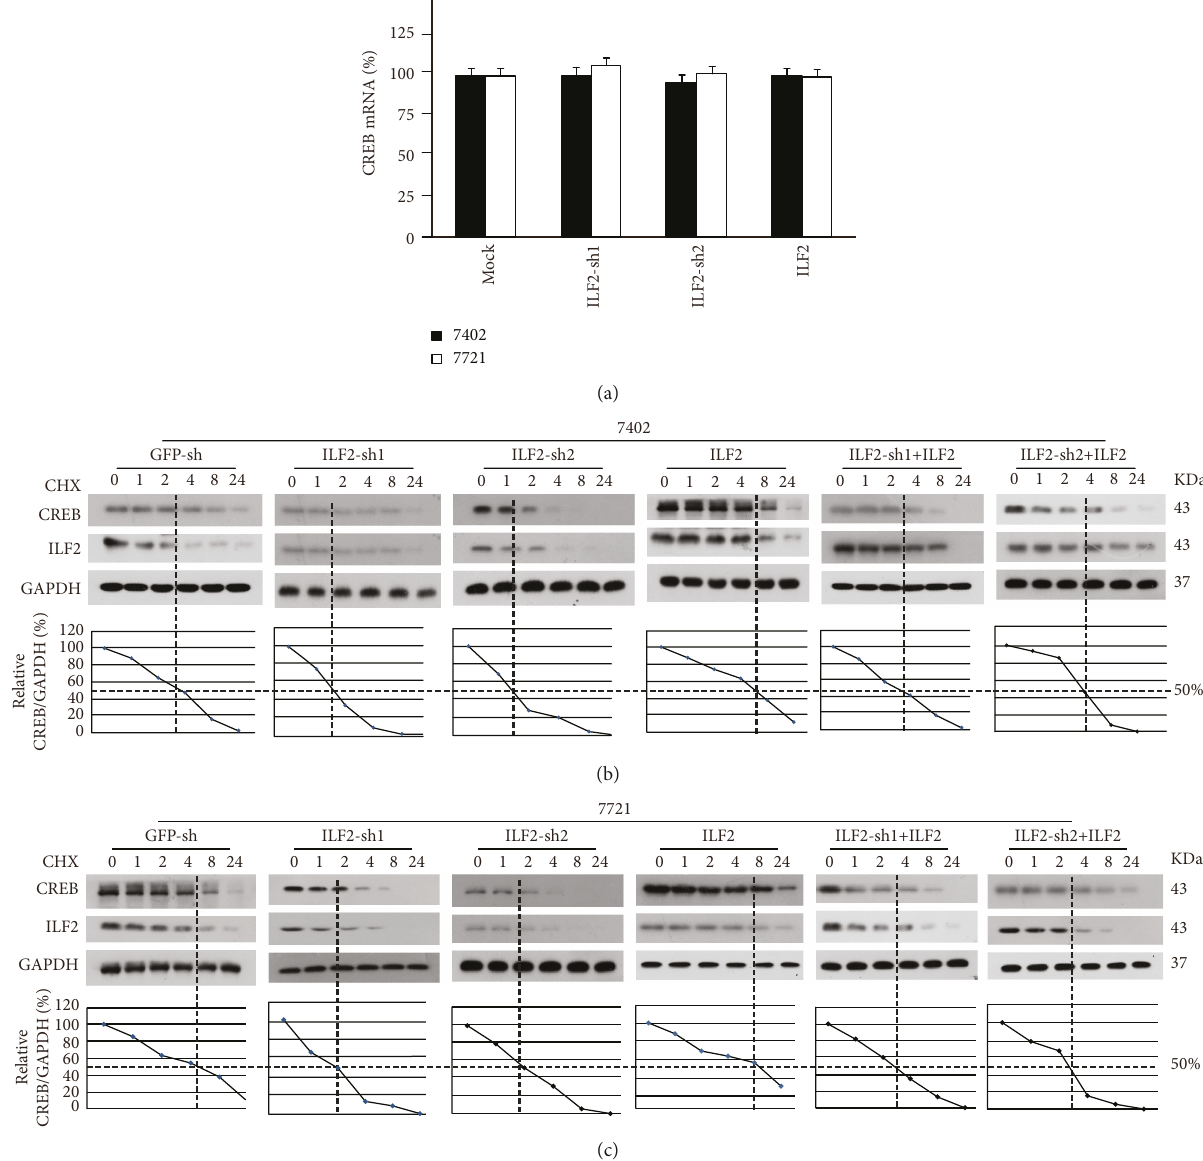
Figure 4: ILF2 enhances CREB protein stability. (a) The mRNA level of CREB was tested by qPCR in control and Bel-7402 or SMMC-7721 cells with knockdown and overexpression of ILF2. (b, c) CHX chase experiments were performed in control and Bel-7402 or SMMC-7721 cells with ILF2 knockdown, ILF2 overexpression, and ILF2 knockdown and ILF2 overexpression simultaneously. The images of ILF2, CREB, and GAPDH were performed by western blotting. The ratios between CREB and GAPDH were calculated with the 0h point arbitrarily set to